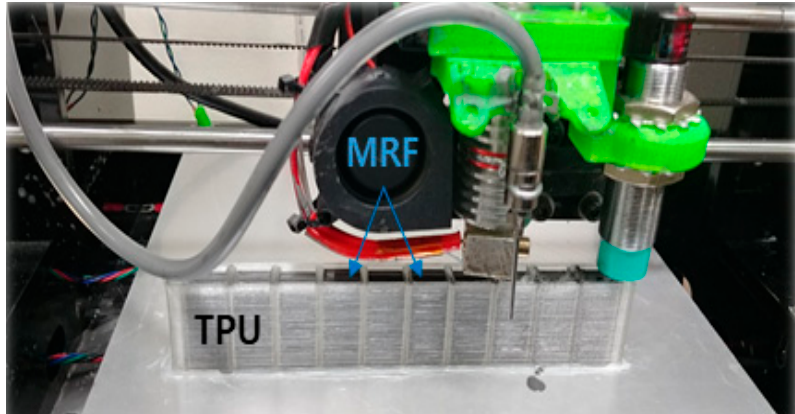
Figure 4. Photograph of the 3D-printing equipment with the MRF and TPU.